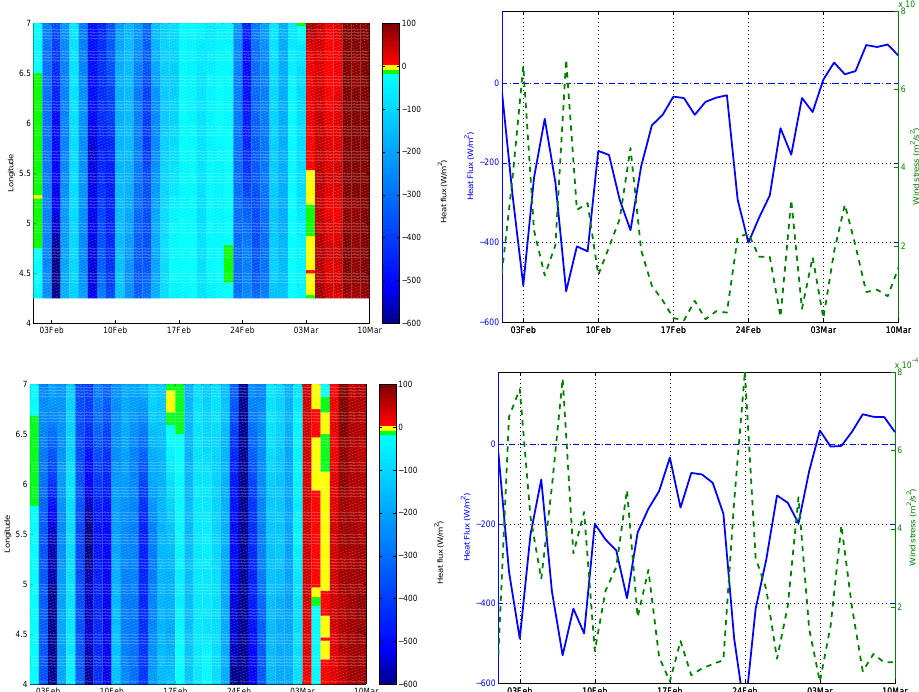
Figure 7. Top panels: Hövmoller diagram of heat fluxes along the glider path on the left, and time series of wind stress and heat fluxes averaged over the area comprising the glider’s path on the right. Bottom panels: the same as for the upper panels, but at 42 ◦ N, i.e., north of the front and in the middle of the area of the spring bloom southeast of the Gulf of Lion (the so-called MEDOC area).